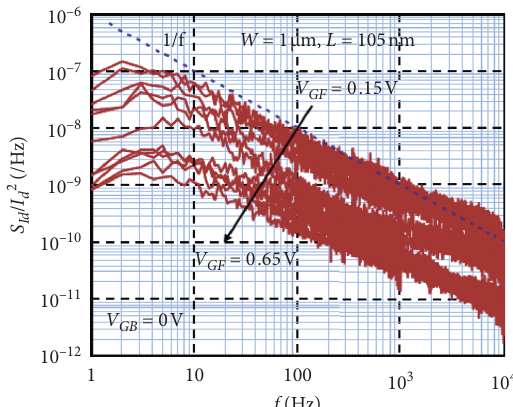
Figure 4: Normalized drain current power spectral density under front gate mode, for nMOS FDSOI with W � 1 μ m and L �